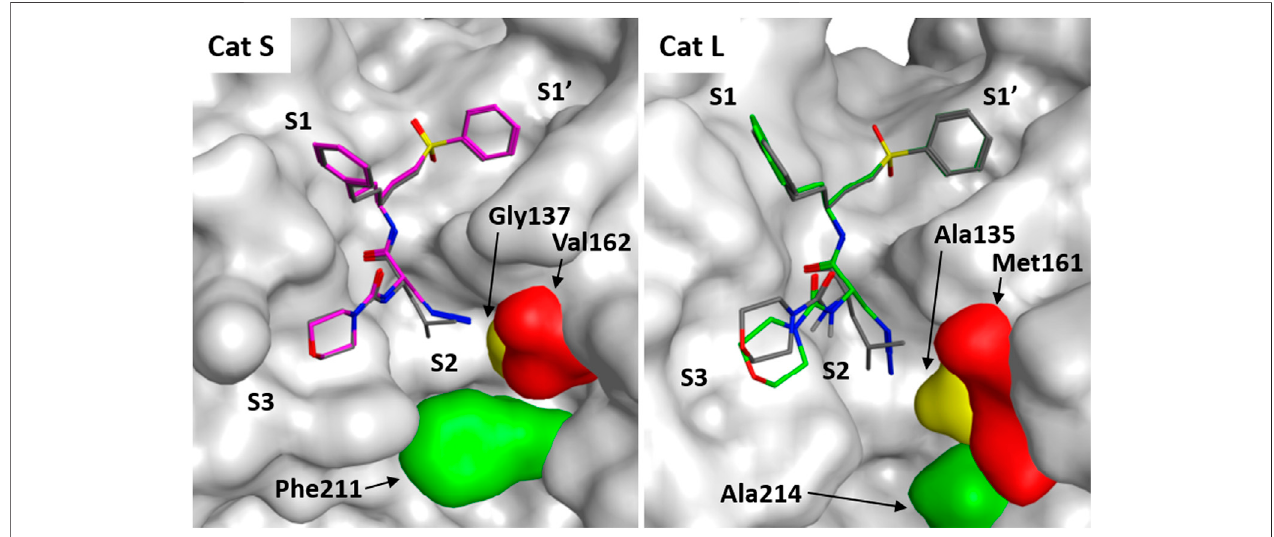
FIGURE 4 | Molecular docking of LHVS analogues in cathepsin S and L. Molecular docking of LHVS (gray) and 3 (purple) in cathepsin S reveals a near identical binding mode for both inhibitors. Whereas docking overlay of LHVS (gray) and 3 (green) in cathepsin L reveals a signi fi cant clash between the azide group and Ala135 in cathepsin L distorting the binding mode. Molecular docking and image preparation was performed with MOE molecular dynamics software.